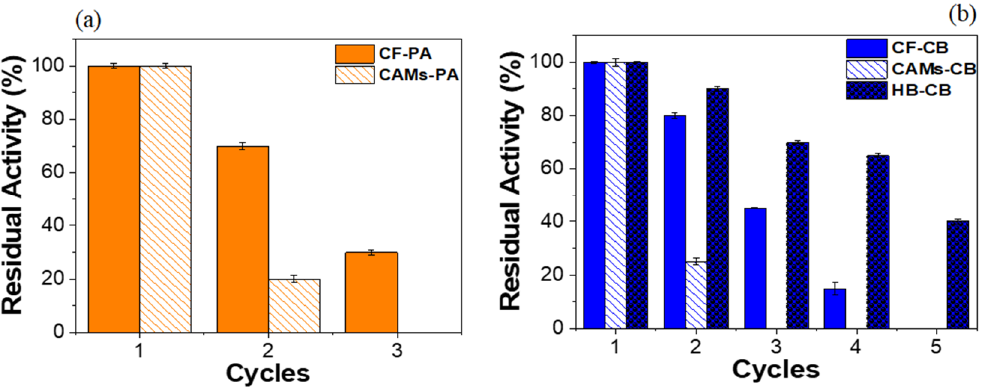
Figure 5. Operational Stability for immobilized radish peroxidase on coconut fiber (CF), calcium alginate microspheres (CAMs) and SBA-15/albumin hybrid (HB): ( a ) physical adsorption (PA), ( b ) covalent binding (CB).